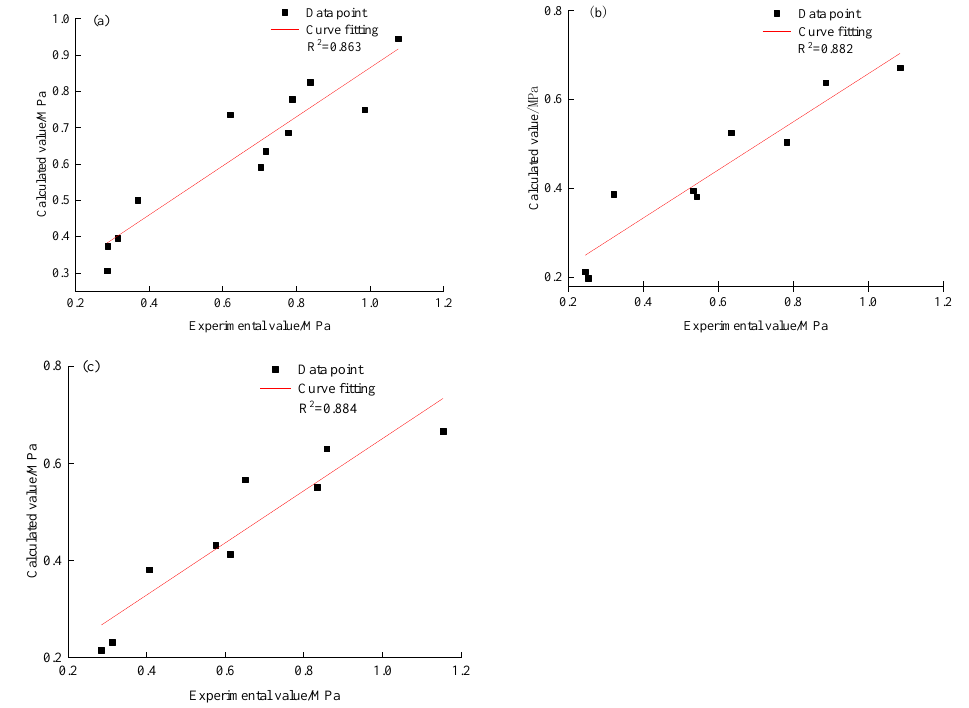
Fig.15 The correlation between the calculated value and the experimental value: (a) semi-solid soil; (b) plastic soil; and (c) soil liquid.